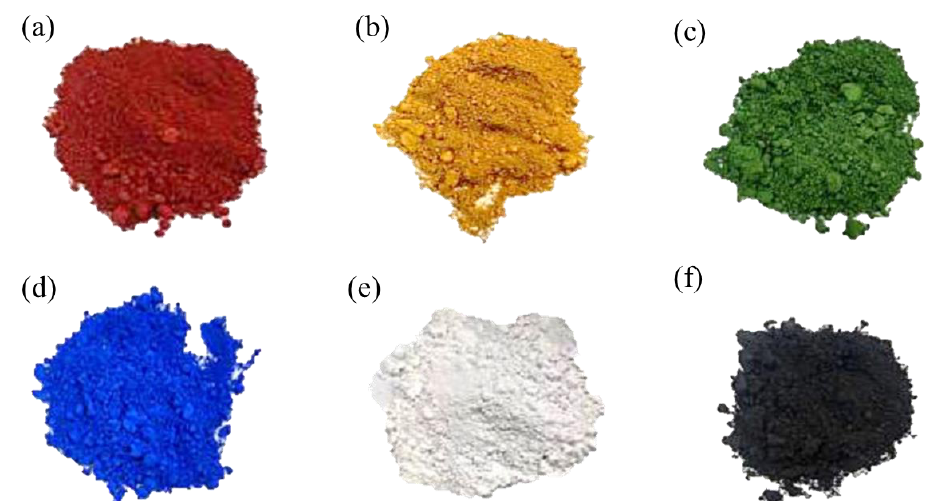
Figure 2. Inorganic color powders: ( a ) red, ( b ) yellow, ( c ) green, ( d ) blue, ( e ) white, and ( f ) black. Table 2. The physical properties of inorganic color powder.